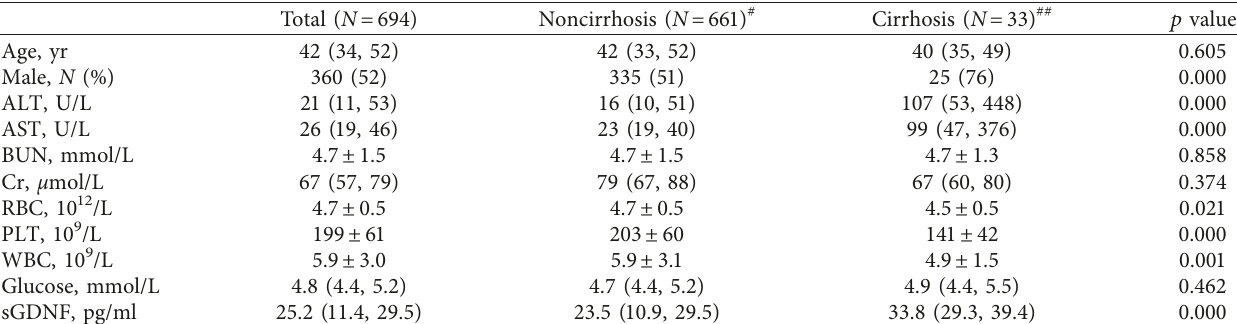
Table 2: Clinical demographics and clinical characteristics of patients in noncirrhosis and cirrhosis groups.